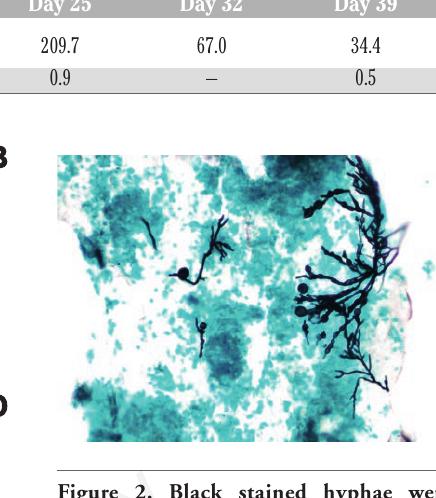
Figure 2. Black stained hyphae were observed in the right lower bronchial lavage (Grocott stain, 200×